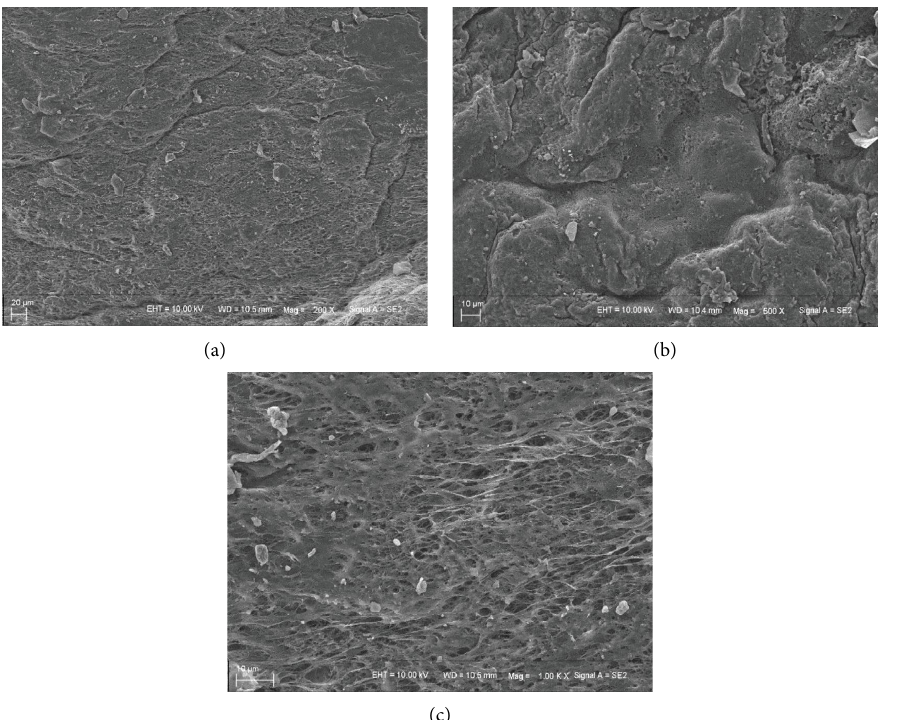
Figure 2: Microstructure of polyaniline/polyvinyl alcohol composite gels. (a) Microstructure of cross section under 200x, (b) microstructure of cross section under 500x, and (c) microstructure of cross section under 1000x.